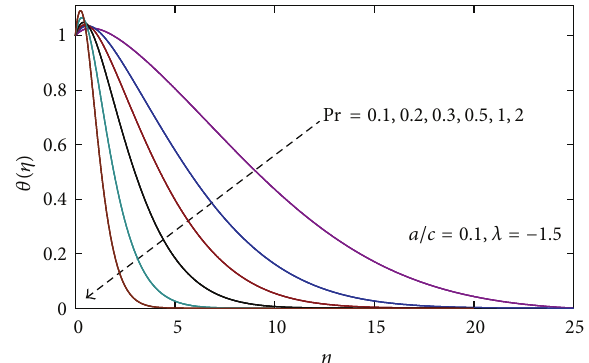
Figure 9: Temperature profiles 𝜃(𝜂) for various values of Pr with 𝑎/𝑐 = 2 and 𝜆 = 1 .